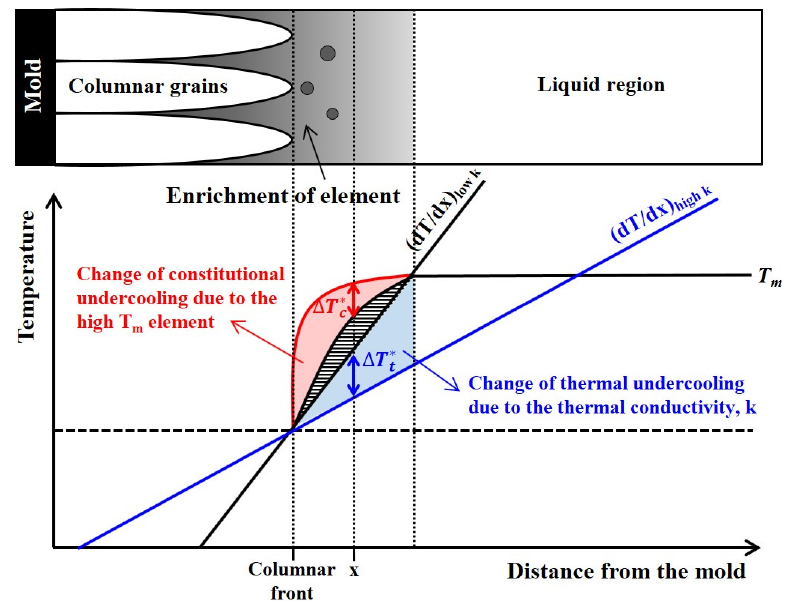
Figure 2. Schematic diagram of solidification and undercooling occurring in front of the solid/liquid interface. The enrichment of high T m and high k elements increase the constitutional undercooling ( ∆ T ∗ c ) and thermal undercooling ( ∆ T ∗ t ), respectively. Both ∆ T ∗ c and ∆ T ∗ t increase the driving force of nucleation.